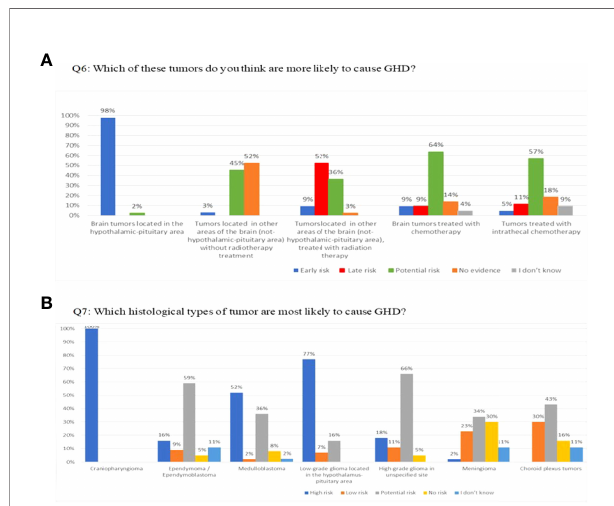
FIGURE 1 | (A) Q6: Which of these tumors do you think are more likely to cause GHD? (B) Q7: Which histological types of tumor are most likely to